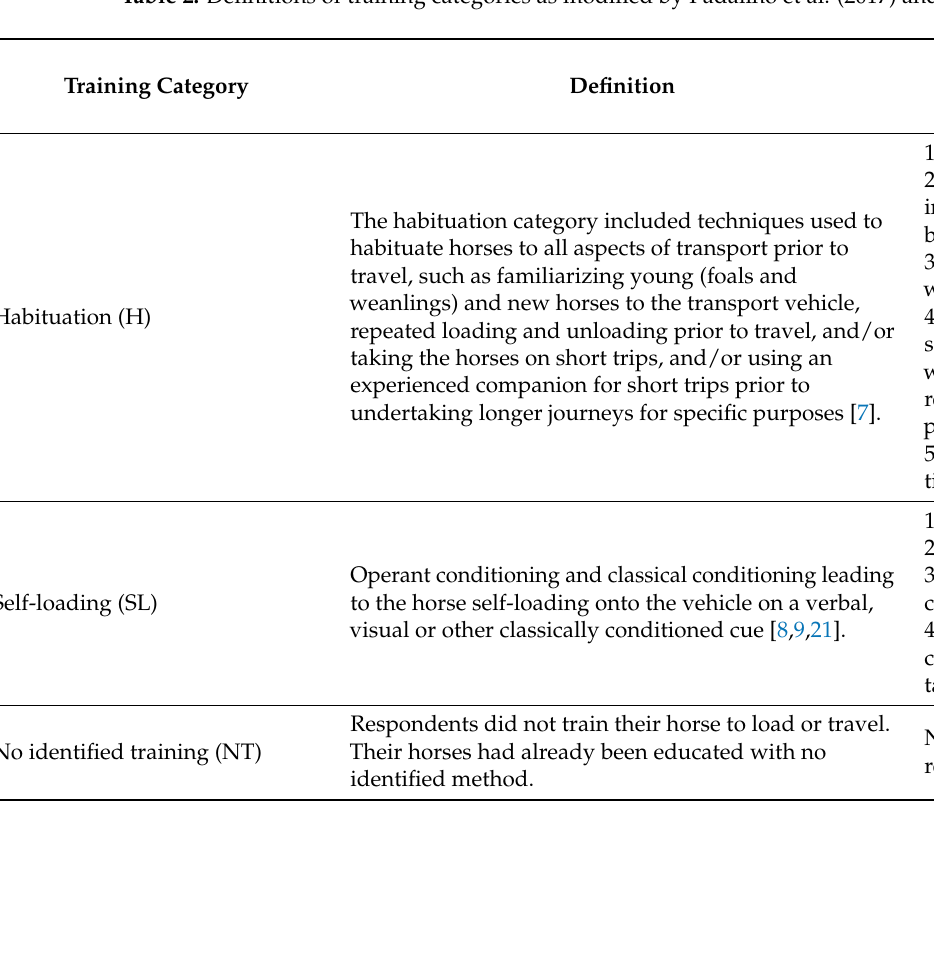
Table 2. Definitions of training categories as modified by Padalino et al. (2017) and examples of respondents’ replies for the training category.